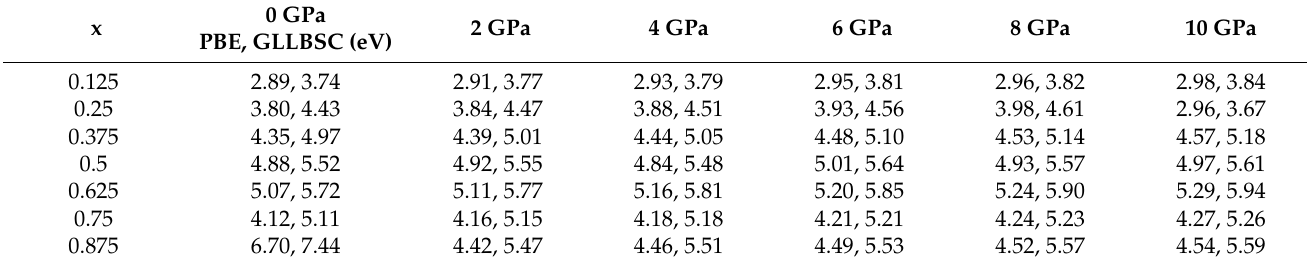
Table A3. Detailed band gap energy ( E g ) of 2 × 2 × 1 wurtzite Zn 1 − x Mg x O (WZ-ZMO2) for